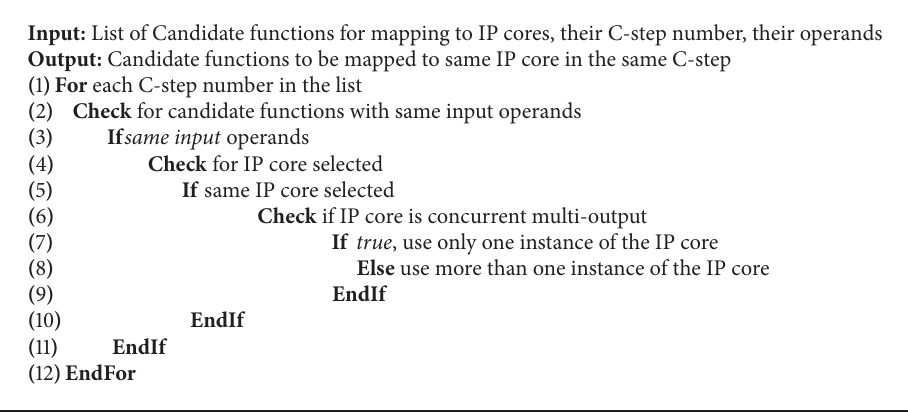
Algorithm 6: IP core dependency resolution